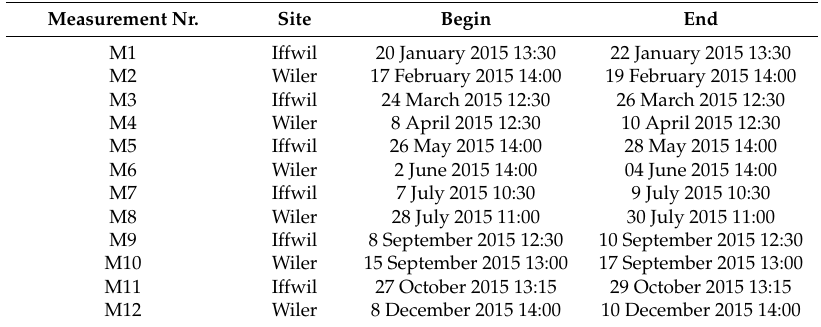
Table 1. Measurement periods at the two sites. “Begin” and “End” mark the times of the 48 h of data used for the evaluation. Measurement Nr. Site